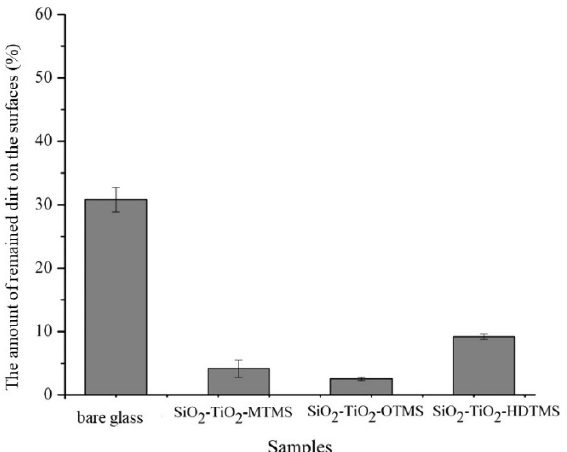
Figure 16. The amount of remaining dirt on the SiO 2 -TiO 2 -OTMS coated glass surface after the self-cleaning test.